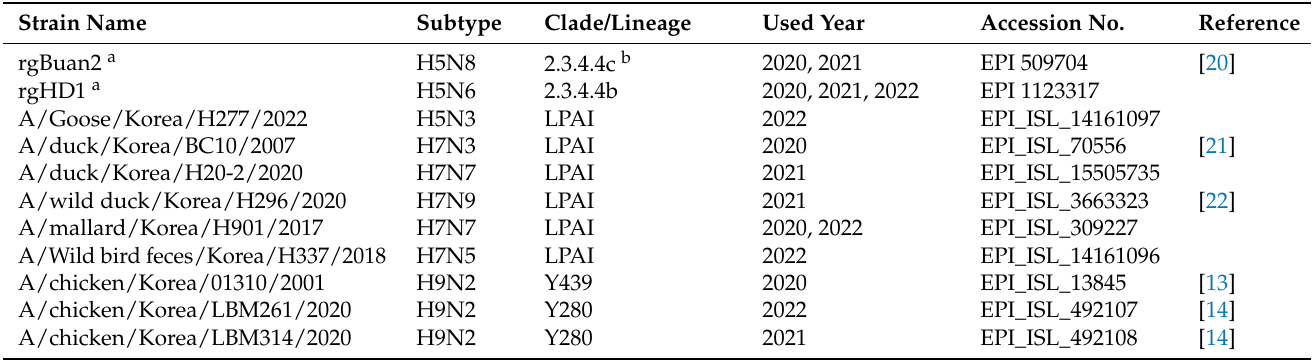
Table 1. Avian influenza A viruses used for the PT